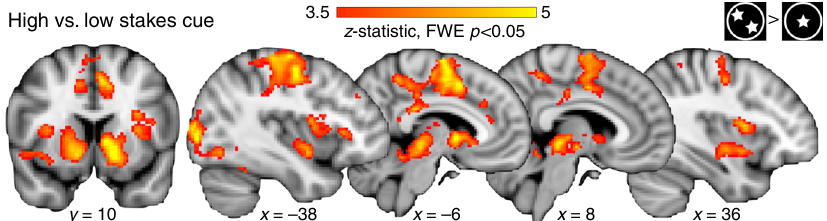
Fig. 6 High stakes versus low stakes cue activity. Statistical map illustrating regions exhibiting greater functional recruitment for high stakes relative to low stakes cues across all participants. Stakes cue recruitment was not associated with age. Contrast represent whole-brain corrected t tests (FWE p